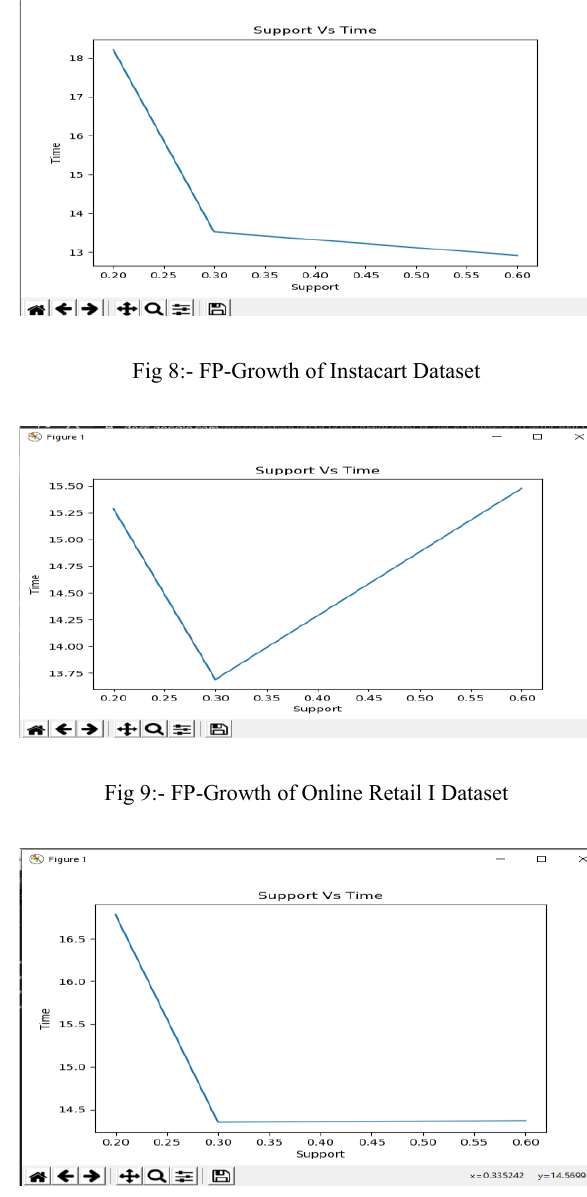
Fig 6:- Apriori Of Online Retail II Dataset